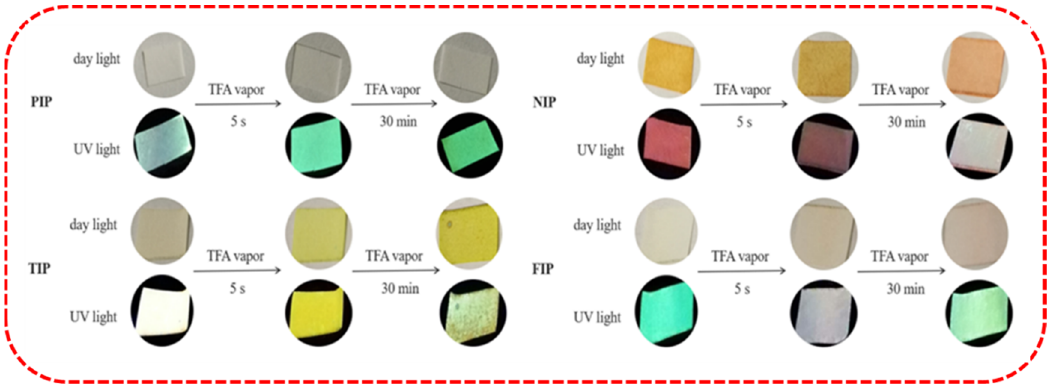
Figure 12. Images of PIP , NIP , TIP, and FIP (size: 1 cm × 1 cm) before and after fuming with TFA vapor under daylight ( upper ) and illumination with 365 nm UV light ( lower ).